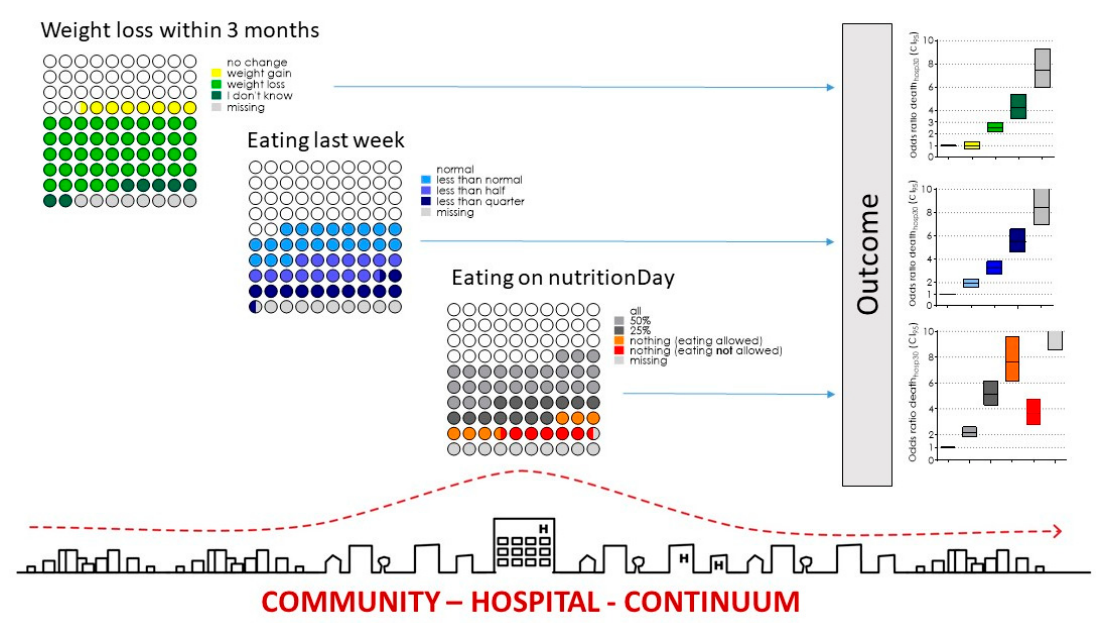
Figure 1. Prevalence of risk factors and association with odds ratio for death in hospital within 30 days after nutritionDay in medical patients. Prevalence is indicated by dots. Each dot represents 1% of the total population. All risk indicators are collected on one single day, the nutritionDay 2006–2015. Odds ratio are indicated with 95% confidence intervals and colours according to risk indicator categories Graph of Community–Hospital–Continuum from Magdalena Maierhofer’s architectural diploma thesis: A Hospital is not a Tree (2016). Table 2. Demographic characteristics and prevalence of nutrition risk factors of patients in the nutritionDay cohort 2006–2015, in the four studied groups. Medical Surgical Long-Term Care